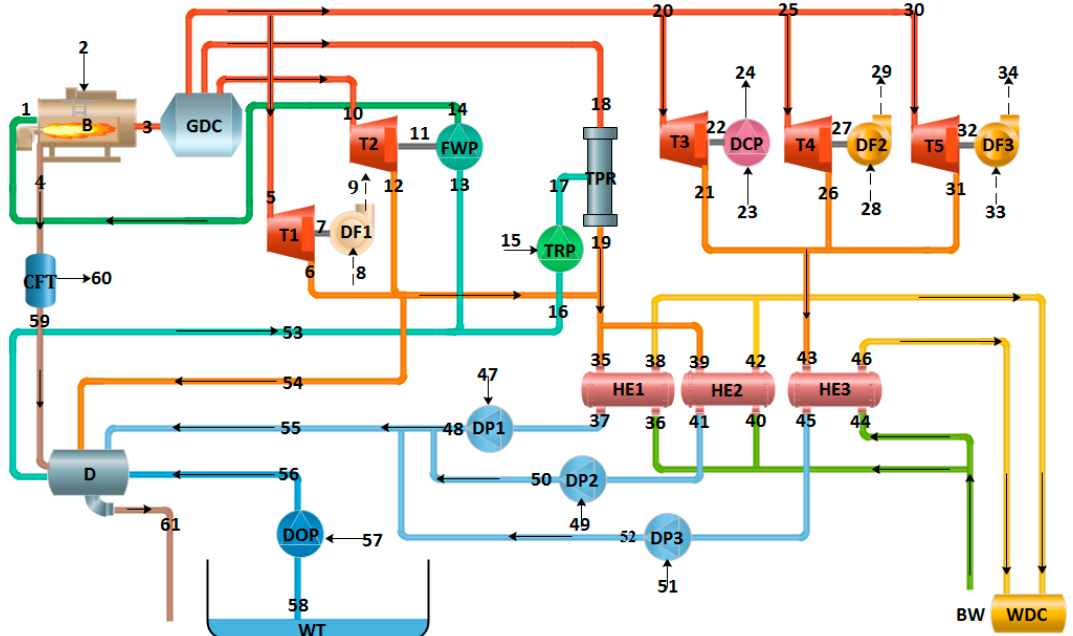
Figure 1. The layout of the CHP system with turbine-driving technology. Key : B-boiler; GDC-gas-distributing cylinder; T-turbine; DF-induced draft fan; FWP-feedwater pump; TPR-temperature and pressure reducer; DP-drain pump; DCP-desulfurization circulating pump; TRP-temperature reduction pump; HE-steam water heat exchanger; DOP-deoxygenation pump; D-deaerator; CFT-continuous blowdown flash tank; BW-back water; WT-water tank; WDC-water distributing cylinder.